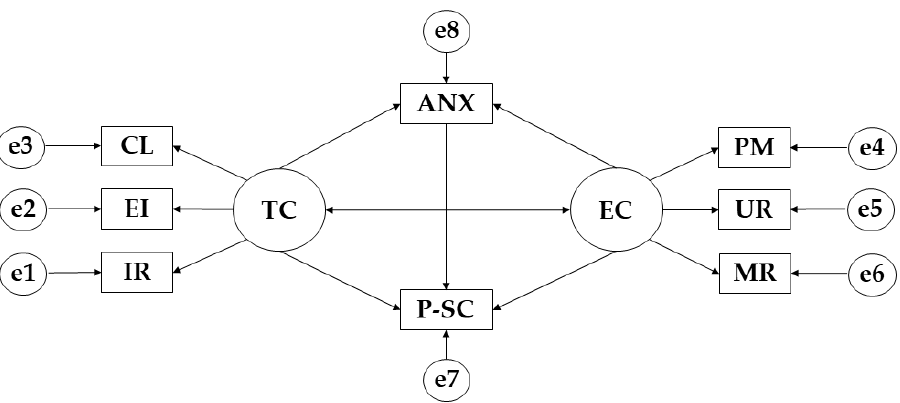
Figure 1. Theoretical Model Proposed. Note: Task Climate (TC); Cooperative Learning (CL); Ef- fort/Improvement (EI); Important Role (IR); Ego Climate (EC); Punishment for Mistakes (PM); Un- equal Recognition (UR); Rivalry between group members (MR); Physical Self-Concept (P-SC); Anx- iety (ANX).